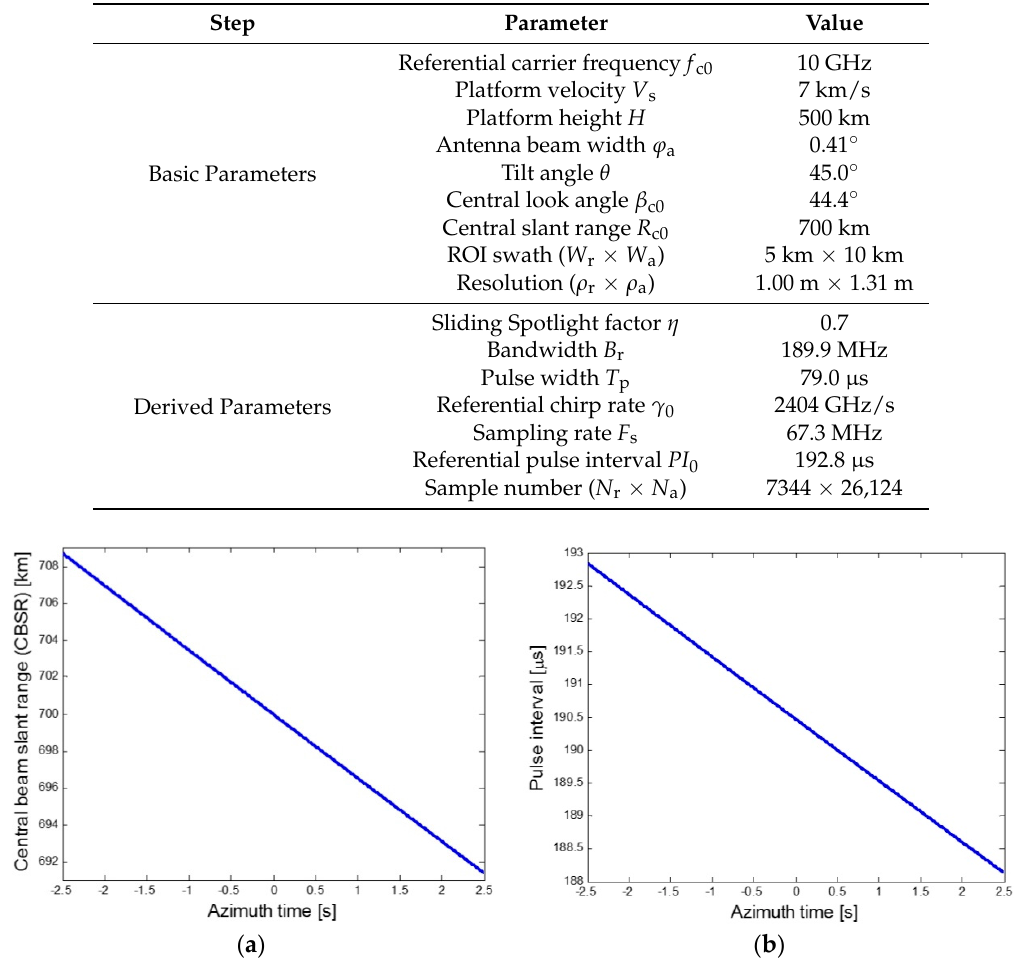
Table 4. Key parameters for the SSS-RSSAR simulation.